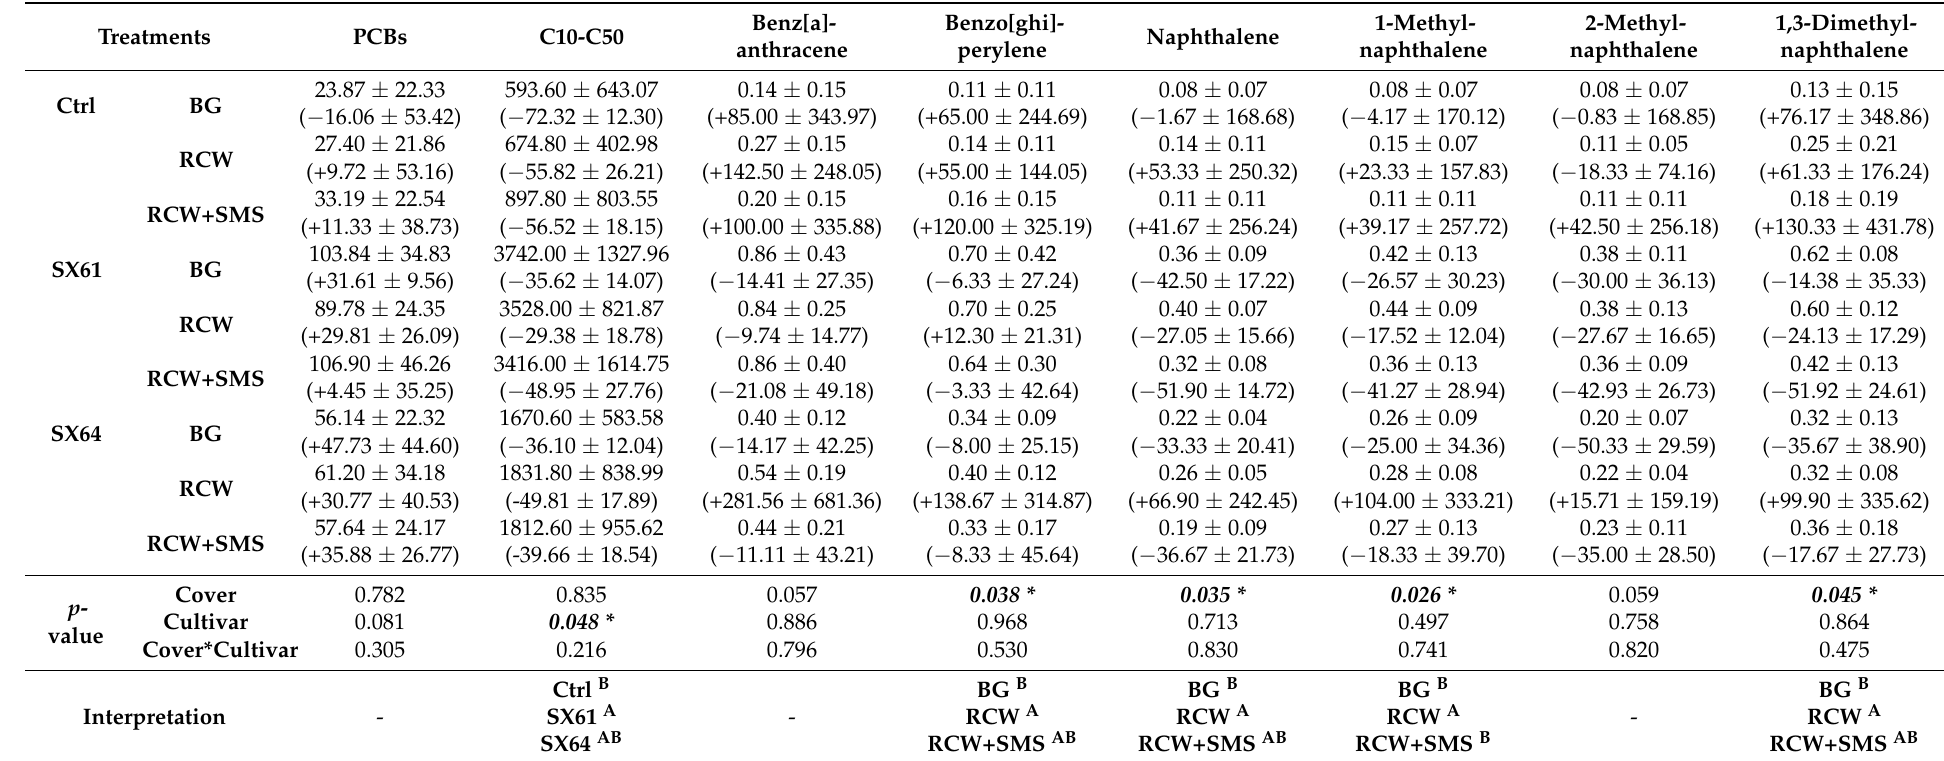
Table 2. Global variation (GV) of soil PCBs, C10-C50 and six